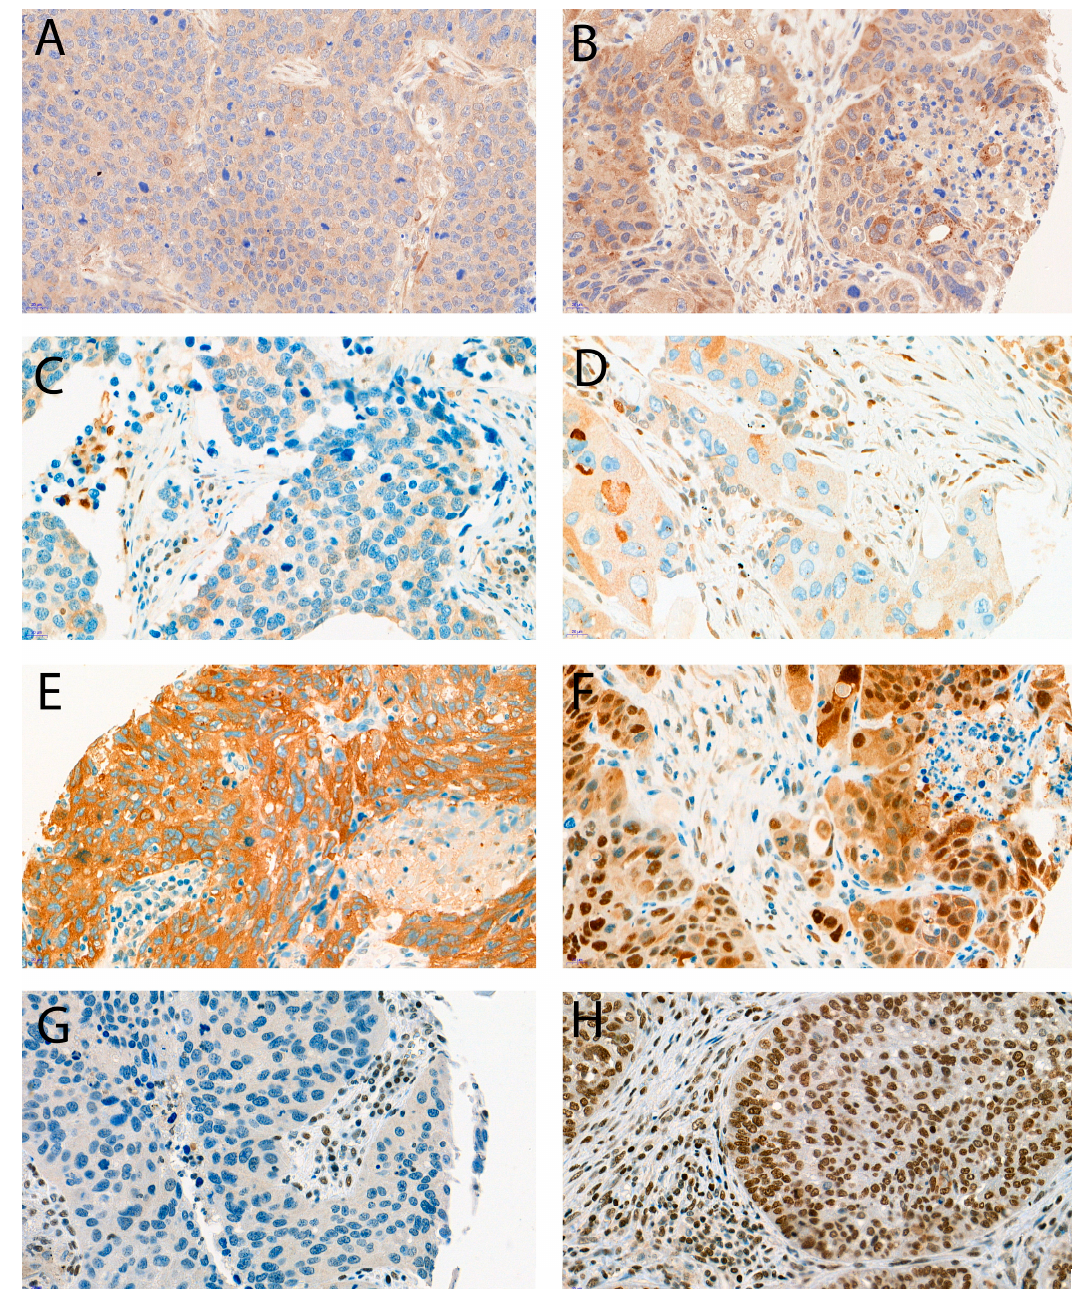
Figure 1. Examples of immunohistochemical stainings; ( A ) LC3B low, ( B ) LC3B high, ( C ) p62 low (any cellular compartment), ( D ) p62 cytoplasmic low, ( E ) p62 cytoplasmic/dot like high, nuclear low, ( F ) p62 cytoplasmic/dot like low, nuclear high, ( G ) HMGB1 low, ( H ) HMGB1 high. Objective magnification, 40 ×